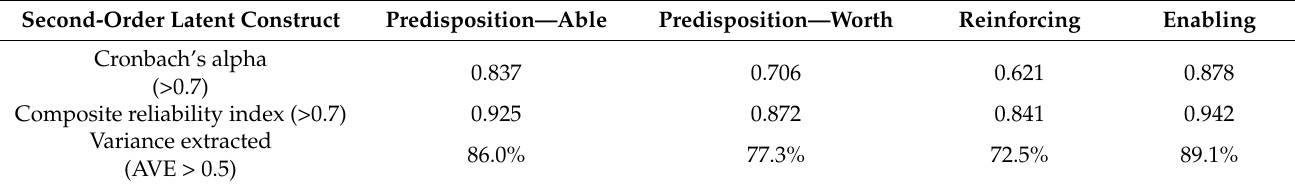
Table 3. The consistency of the measurement of the second-order model.